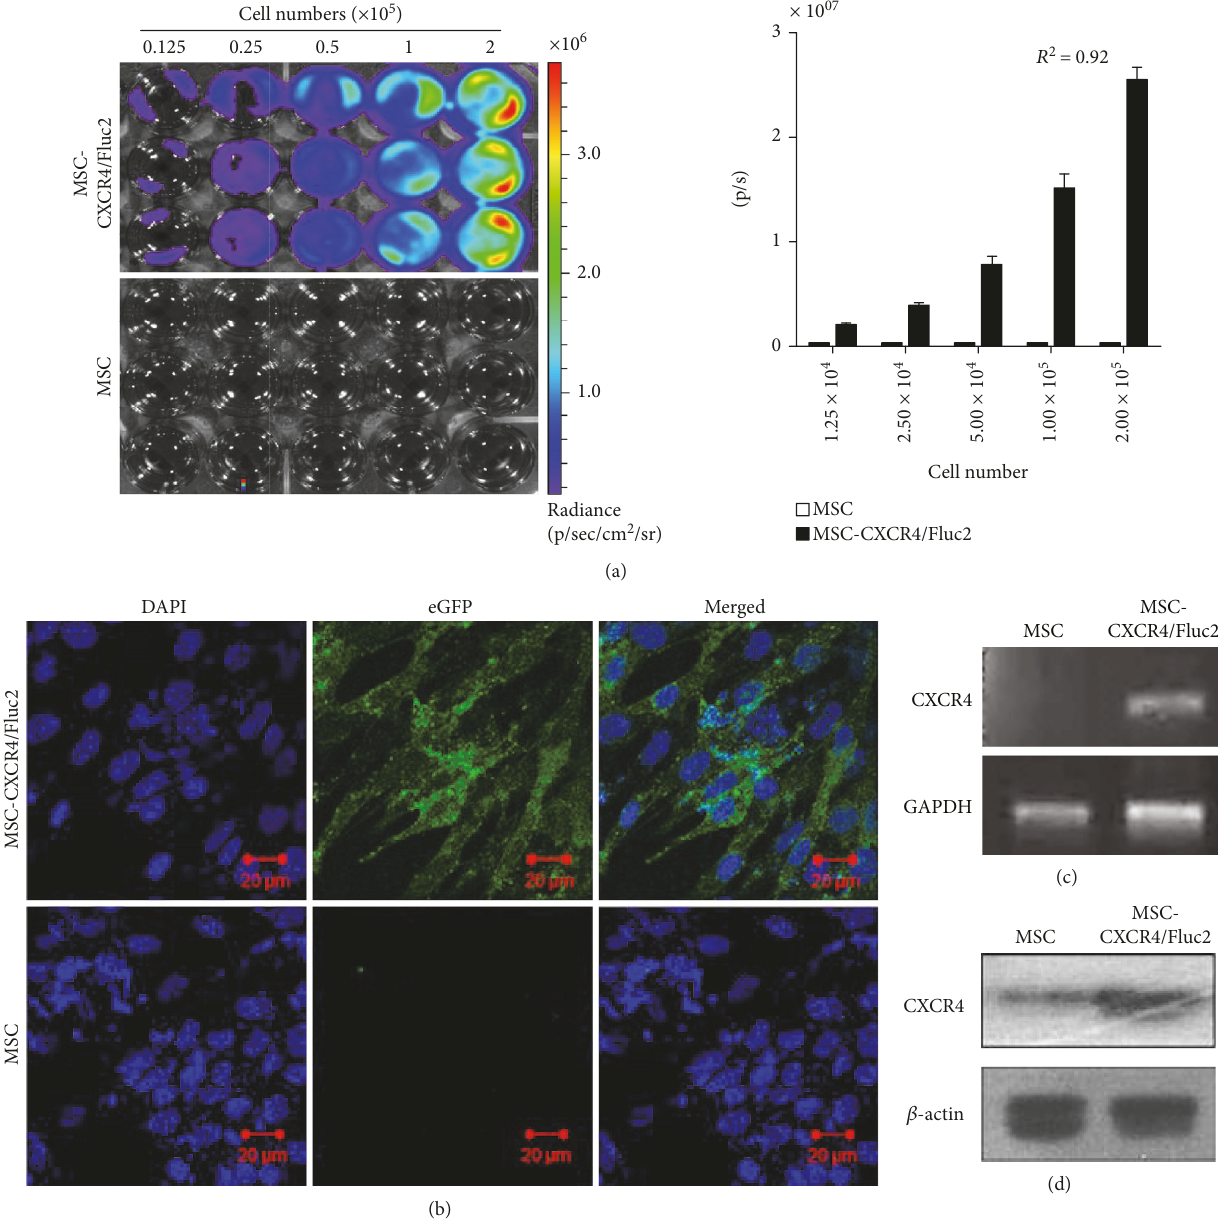
Figure 1: Transduction of CXCR4 in mesenchymal stromal cells (MSCs) with reporter genes. (a) Fluc activity and quantitative bioluminescent imaging (BLI) data of CXCR4-transduced MSCs with di ff erent cell numbers. (b) Enhanced green fl uorescent protein (eGFP) expression analysis by confocal microscopy imaging and (c) CXCR4 mRNA expression analysis by RT-PCR. (d) Protein expression of CXCR4 by Western blot